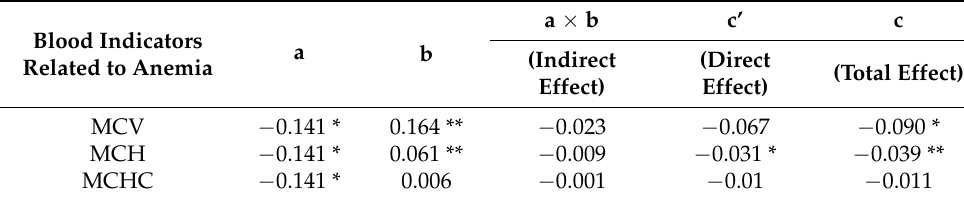
Table 5. Mediation analysis of long-term PM exposure (sensor PM2.5 − lag10) for blood indicators related to